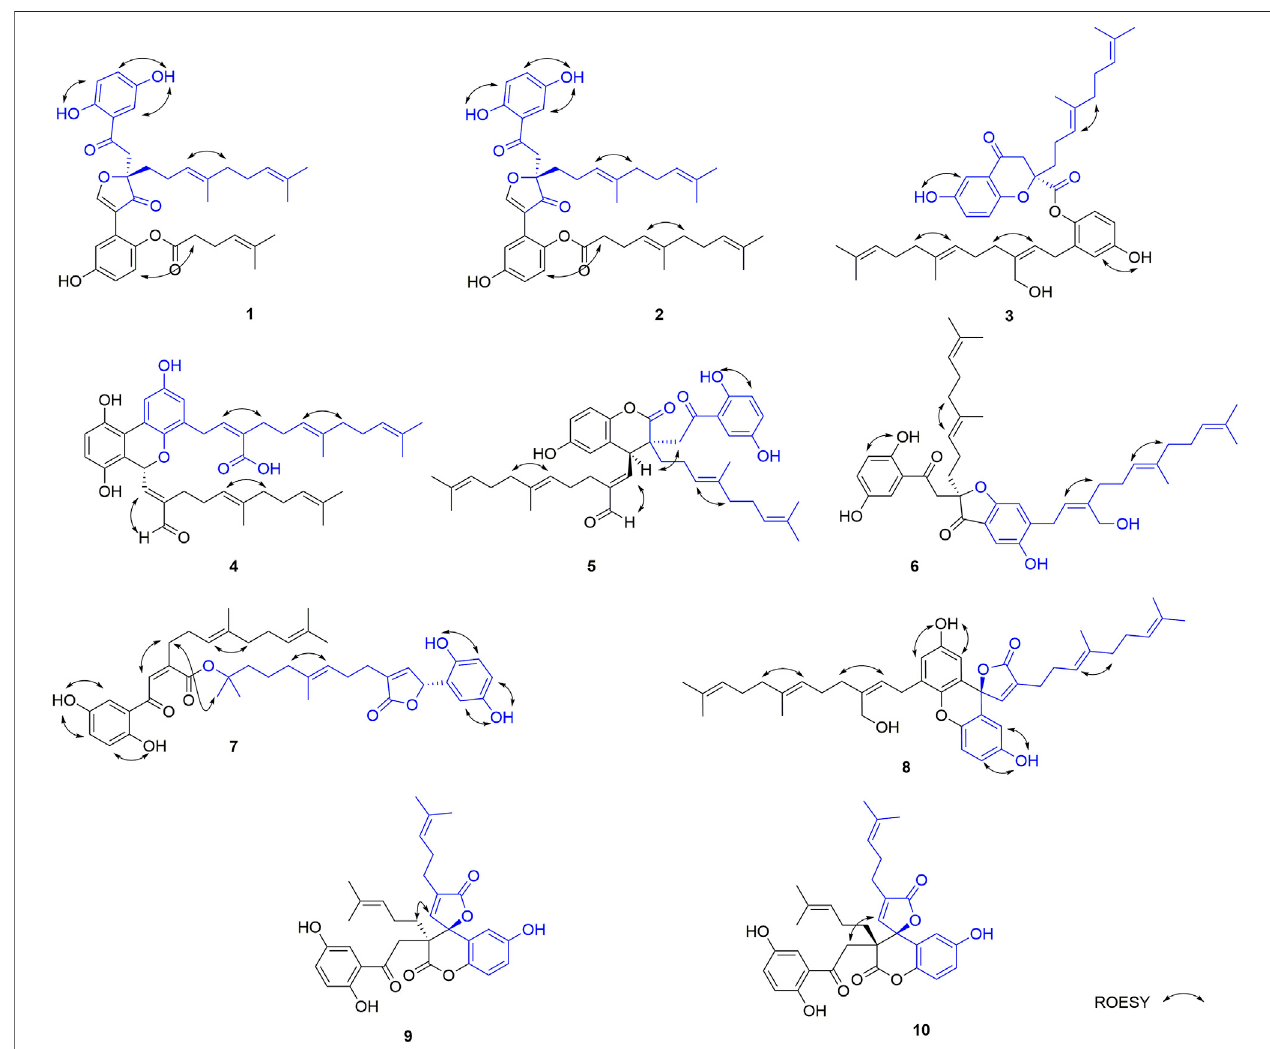
FIGURE 3 | Key ROESY correlations of 1 – 10